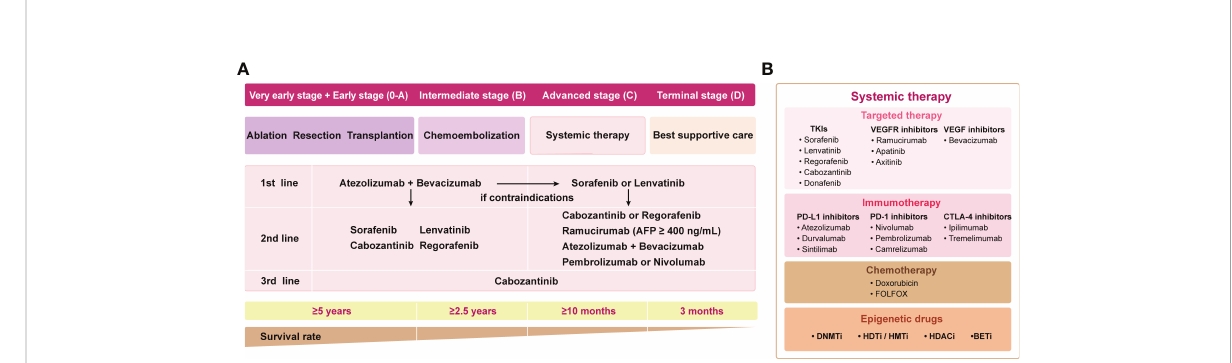
FIGURE 1 The landscape of systemic therapy for HCC treatment strategies. (A) The guidelines aresorted out and summarized by 2018 ASCO, 2018 AASLD,and 2020 EASL. The clinical stages of the patients arede fi ned according to BCLC. (B) Maindrugsfor systemic therapy.TKI,Multi-tyrosine kinase inhibitor; VEGFR,vascular endothelial growth factor receptor; VEGF, vascular endothelial growth factor; ASCO, American Society of Clinical Oncology; AASLD, American Associationfor the Study ofLiverDiseases; EASL, EuropeanAssociation for the Study of the Liver;BCLC,Barcelona Clinic